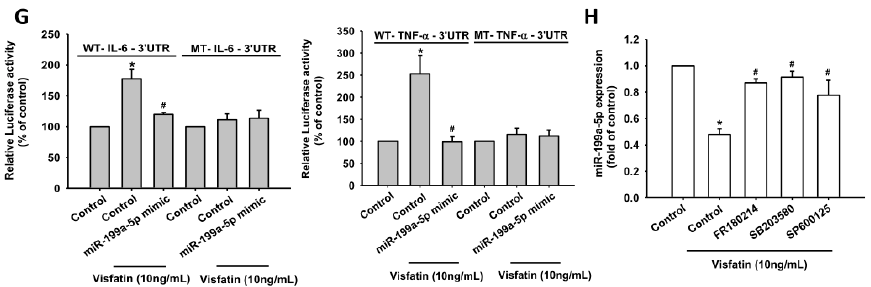
Figure 5. Visfatin increases IL-6 and TNF- α expression via inhibition of miR-199a-5p through the ERK, p38 and JNK signaling pathways. ( A ) Searches of three online computational algorithms (TargetScan, miRWalk and miRanda) for candidate miRNAs that target the IL-6 and TNF- α regions revealed the involvement of miR-199a-5p; ( B ) OASFs were incubated with visfatin for 24 h; miR-199a-5p expression was assessed by qPCR; ( C – E ) OASFs were transfected with miR-199a-5p mimic for 24 h, followed by stimulation with visfatin for 24 h; IL-6 and TNF- α expression was examined by qPCR, Western blot and ELISA assay; ( F ) Schematic 3 ′ -UTR representation of human IL-6 and TNF- α containing the miR-199a-5p binding site; ( G ) OASFs were transfected with indicated luciferase plasmids before incubation with visfatin for 24 h; Luciferase activity was assessed; ( H ) OASFs were pretreated with ERK, p38, and JNK inhibitors for 30 min followed by stimulation with visfatin (30 ng/mL) for 24 h; miR-199a-5p expression was examined by qPCR. Results are expressed as the mean ± SEM. * p < 0.05 as compared with baseline. # p < 0.05 as compared with the visfatin-treated group.